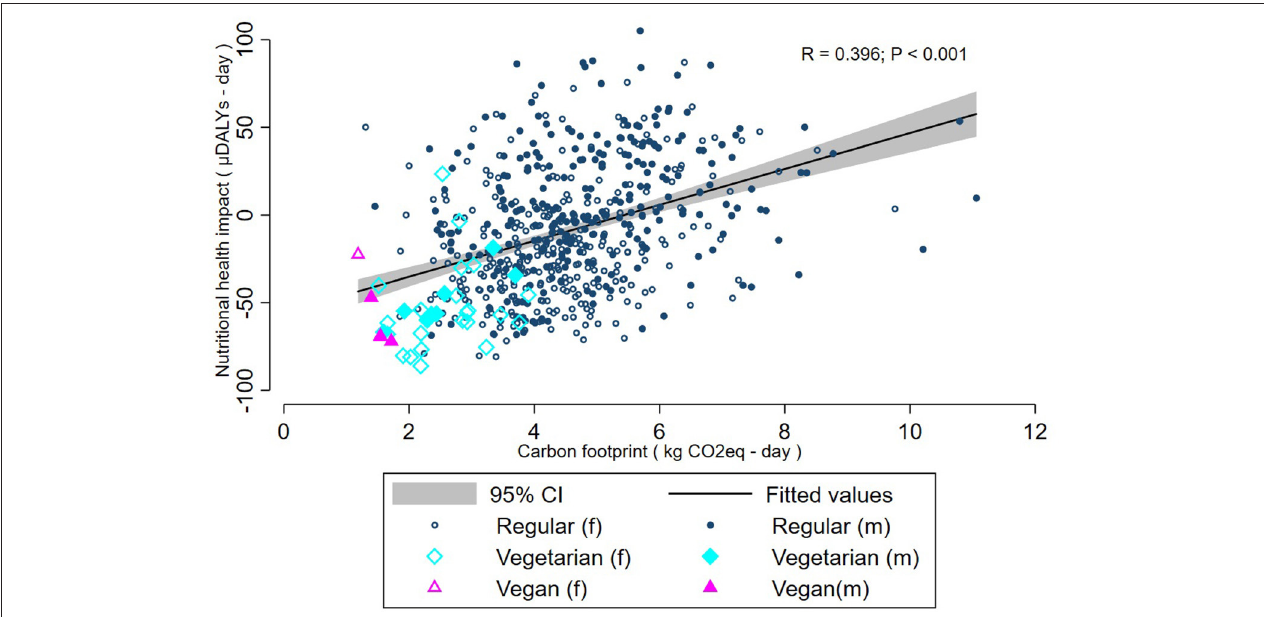
FIGURE 3 | Human health impact of each individual’s surveyed diet as a function of its carbon footprint (y = − 55.8 +